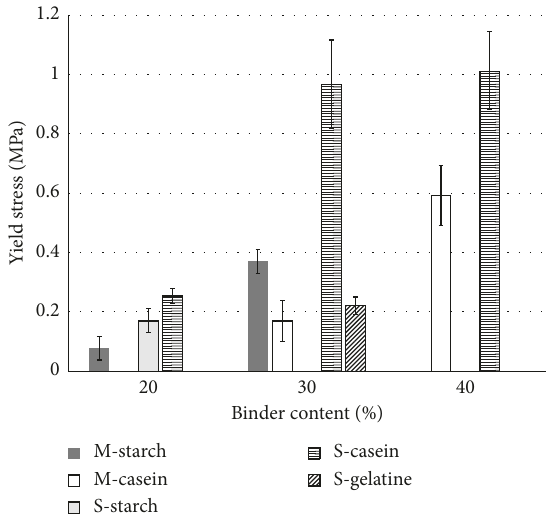
Figure 4: Yield bending